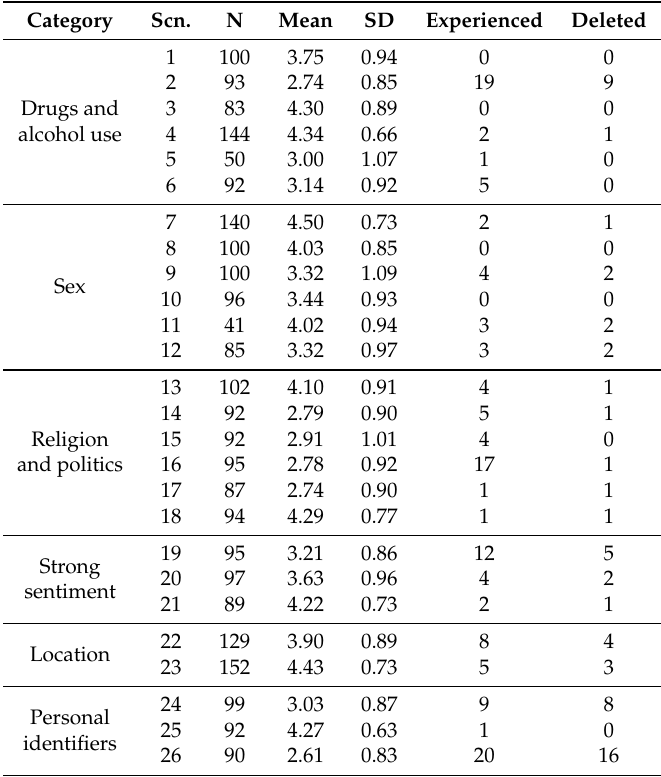
Table 2. Participant’s severity evaluation of the